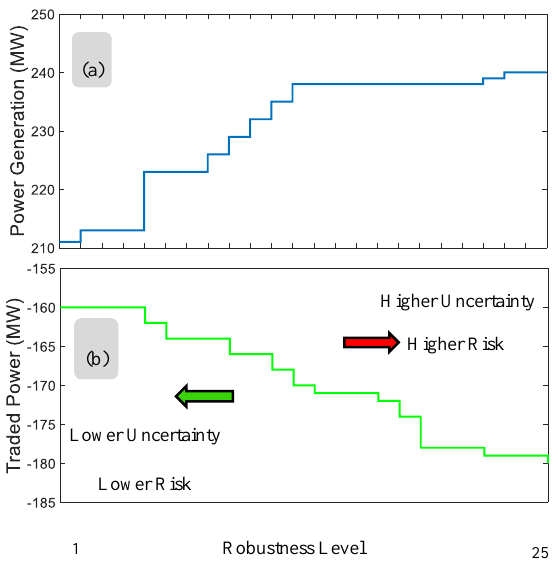
Figure 16. Robust decisions of the ORI in the uncertain electricity market ( a ) Power generation; ( b ) Traded power.